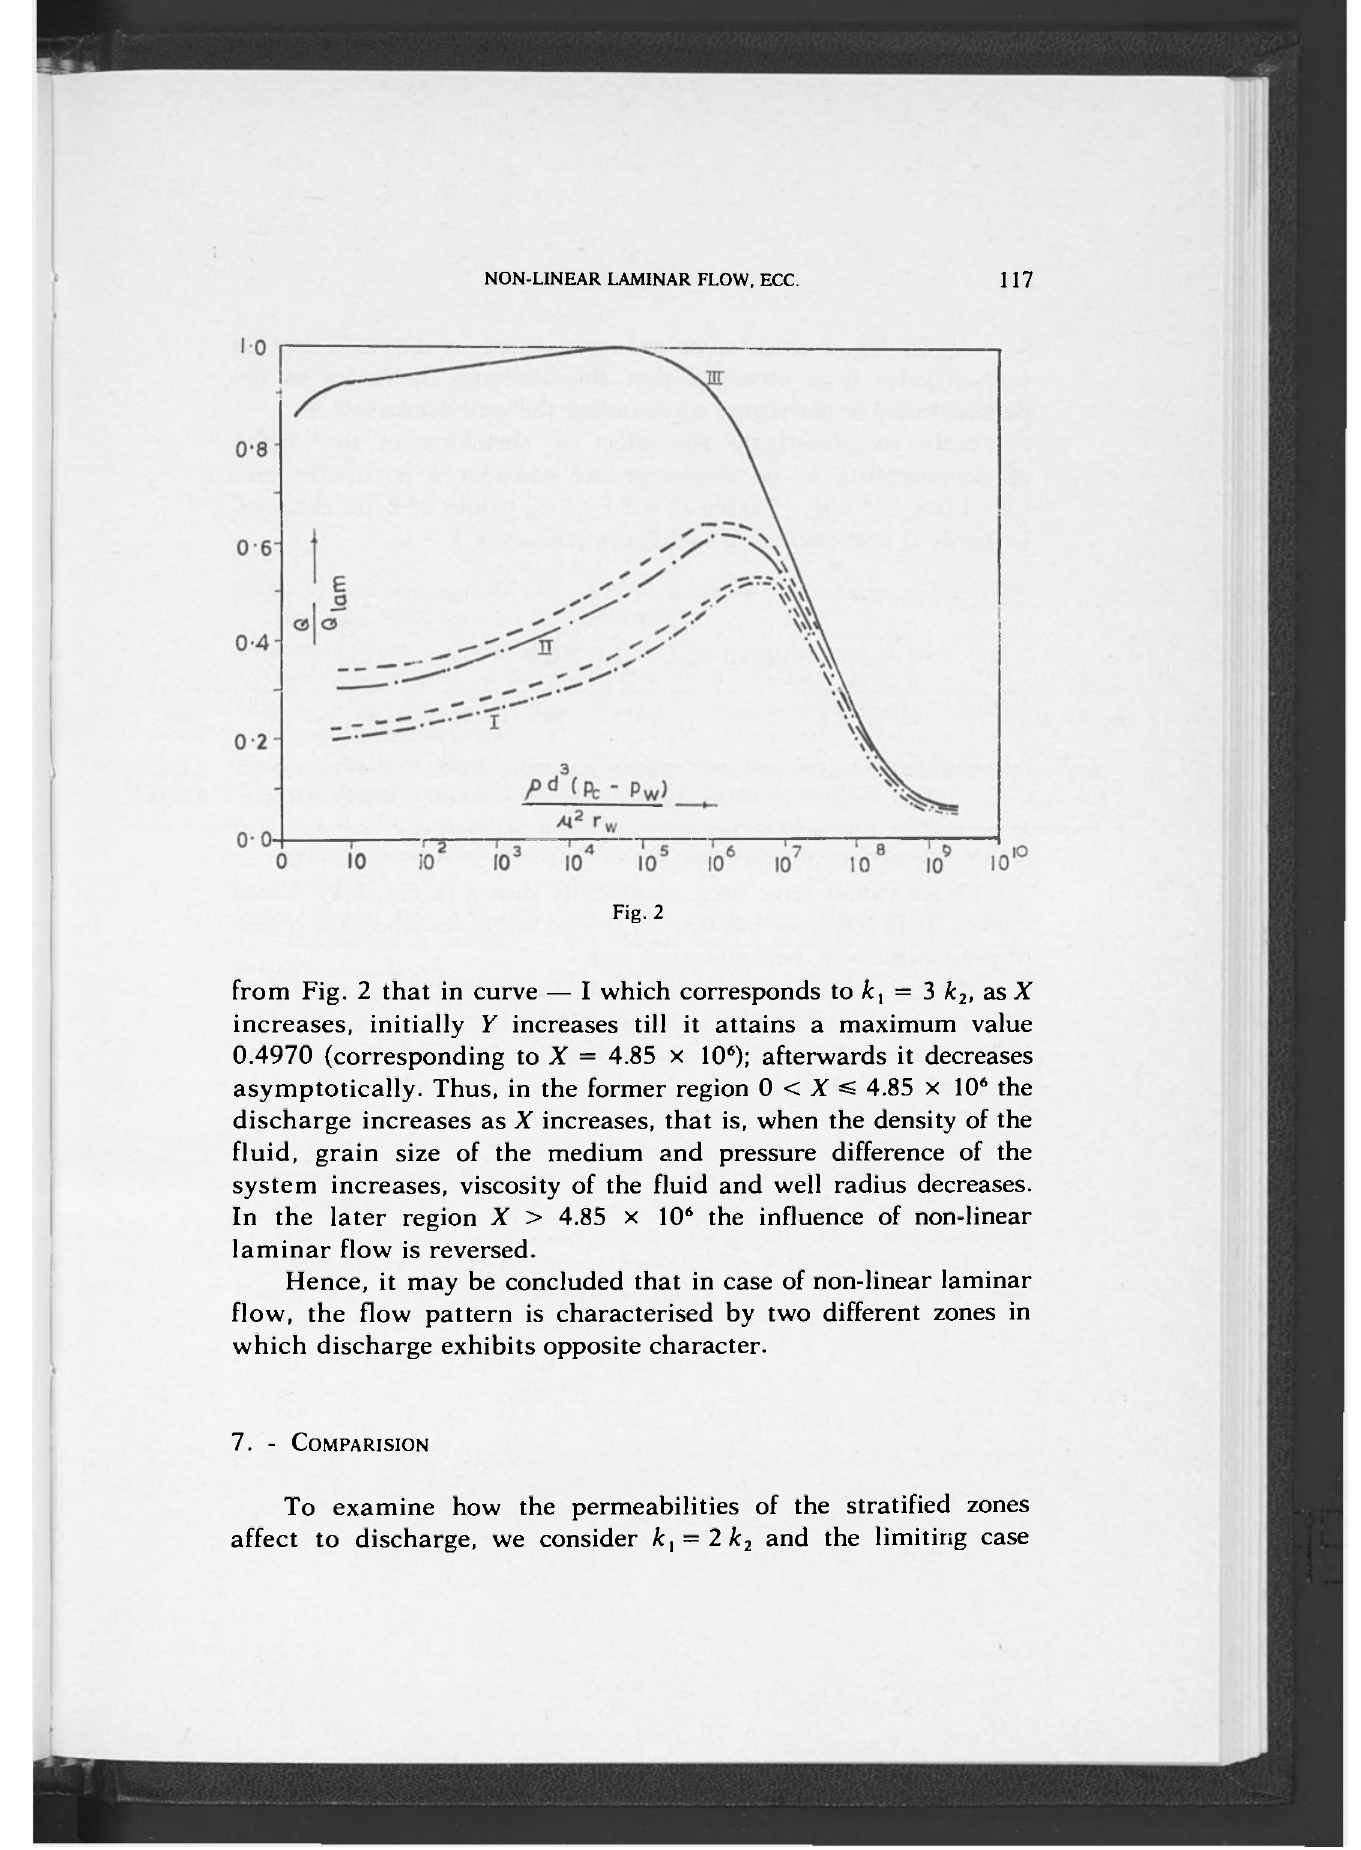
from Fig. 2 that in curve — I which corresponds to A:, = 3 k increases, initially Y increases till it attains a maximum value 0.4970 (corresponding to X = 4.85 x 10 6 ); afterwards it